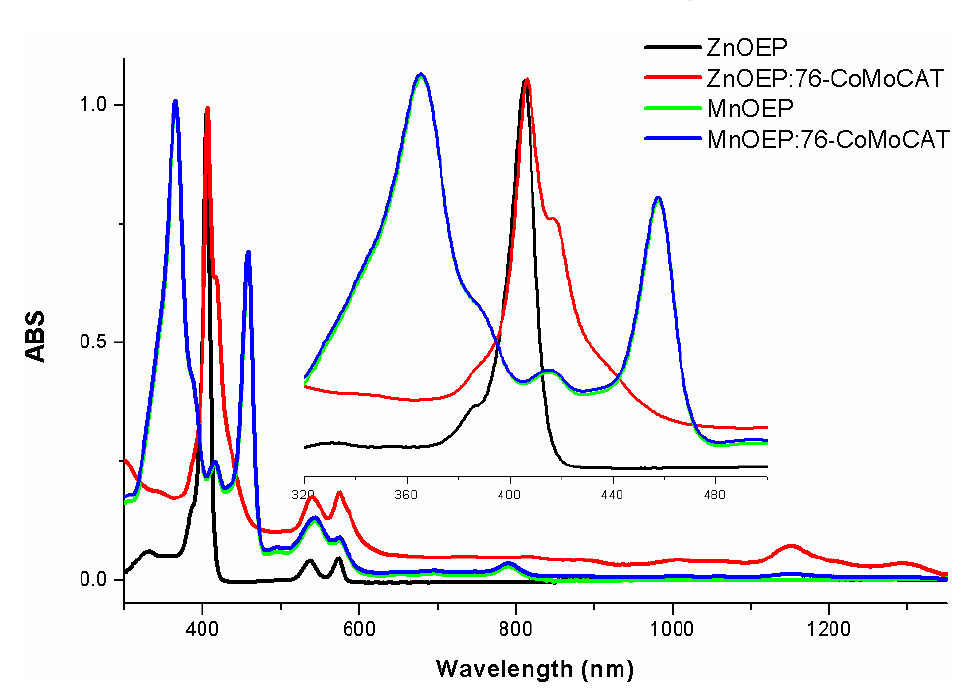
Figure 3. UV-Vis–NIR spectra of ZnOEP and MnOEP in methanol and the supernatant after extraction of 76-CoMoCAT with ZnOEP and MnOEP in methanol. The spectra